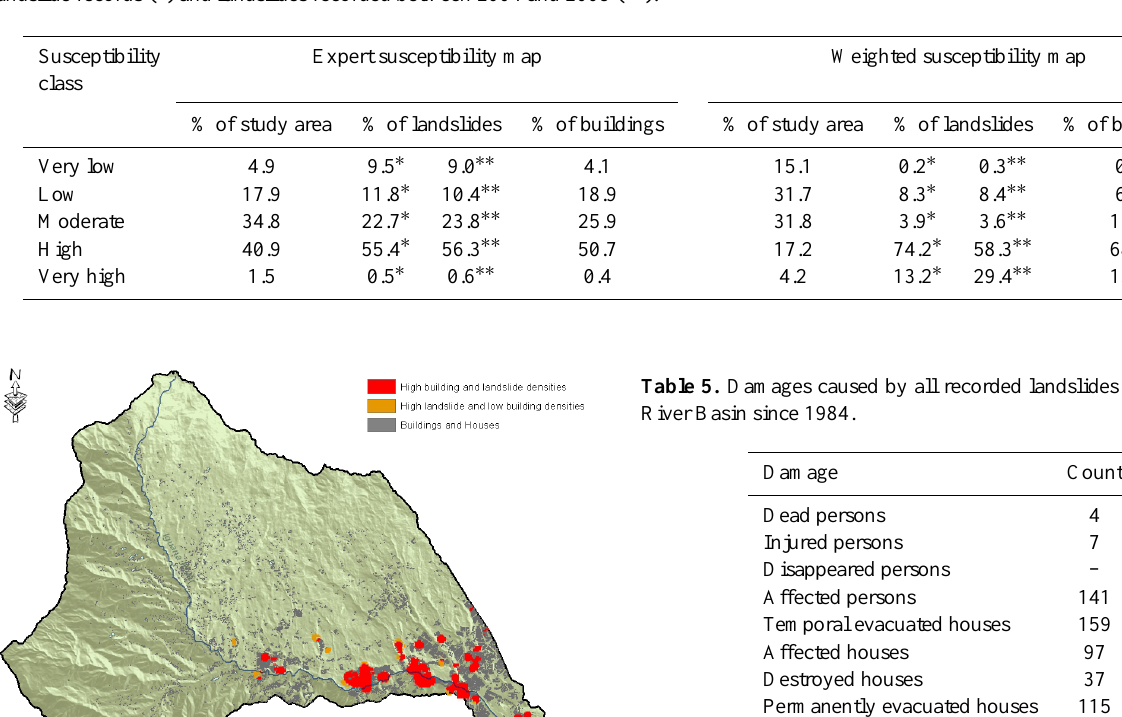
Fig. 4. Expert based (left) and weighted (right) landslides susceptibility map. Table 4. Comparison of the expert-based and weighted landslide susceptibility maps of the Iguan´a River Basin using the all available landslide records ( ∗ ) and landslides recorded between 2004 and 2008 ( ∗∗ ).